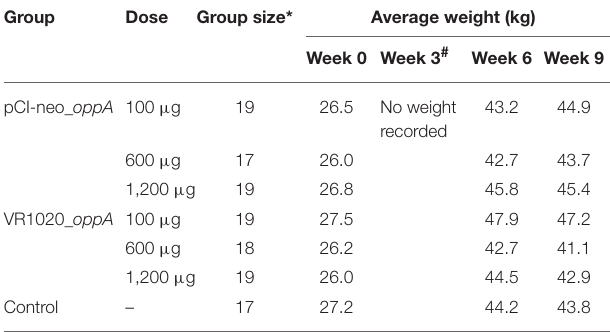
TABLE 1 | The average weight gain of ostriches measured during the course of the